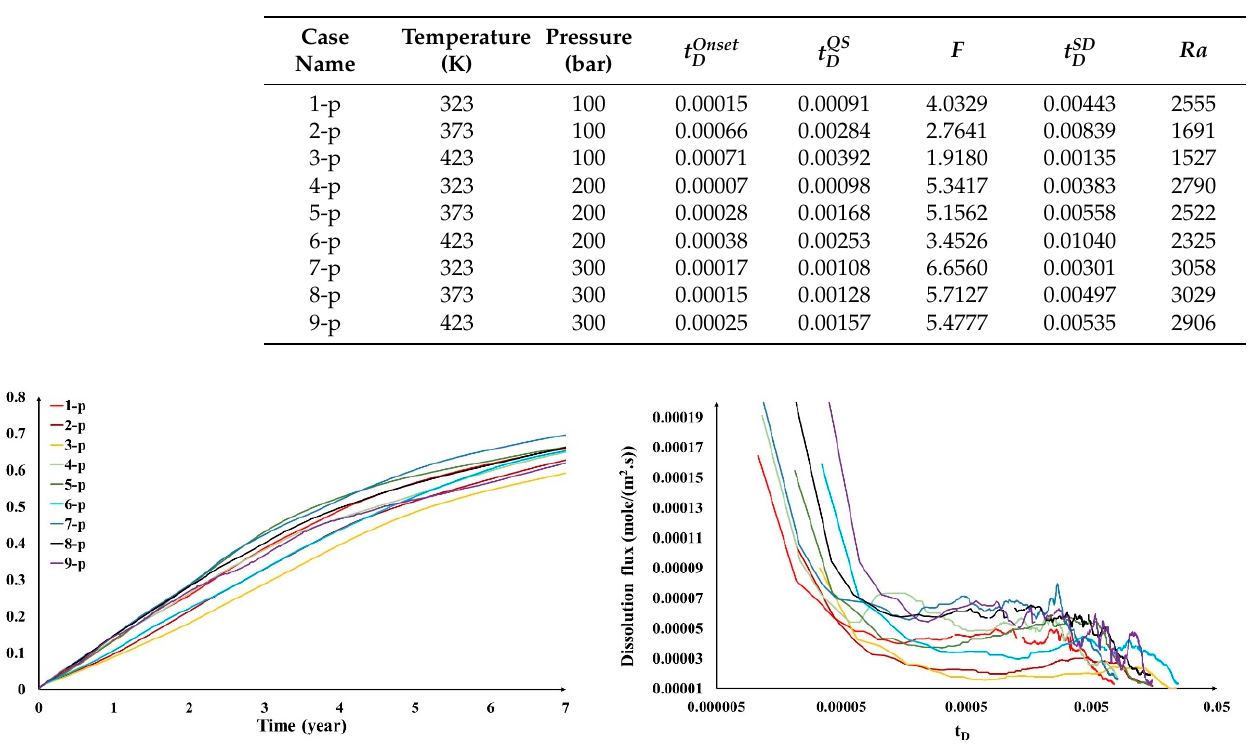
Figure 1. A schematic of different regimes in a dissolution process. Table 3. Details of the pure cases.